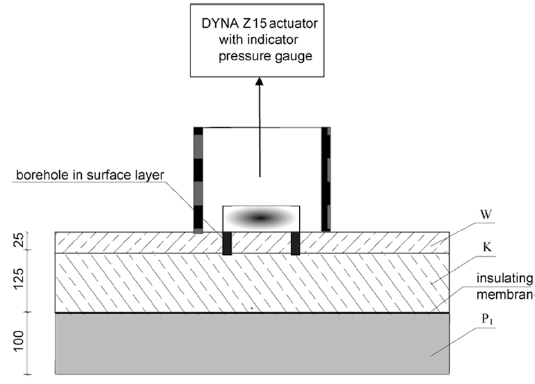
Fig. 7. Schematic of pull-off test rig